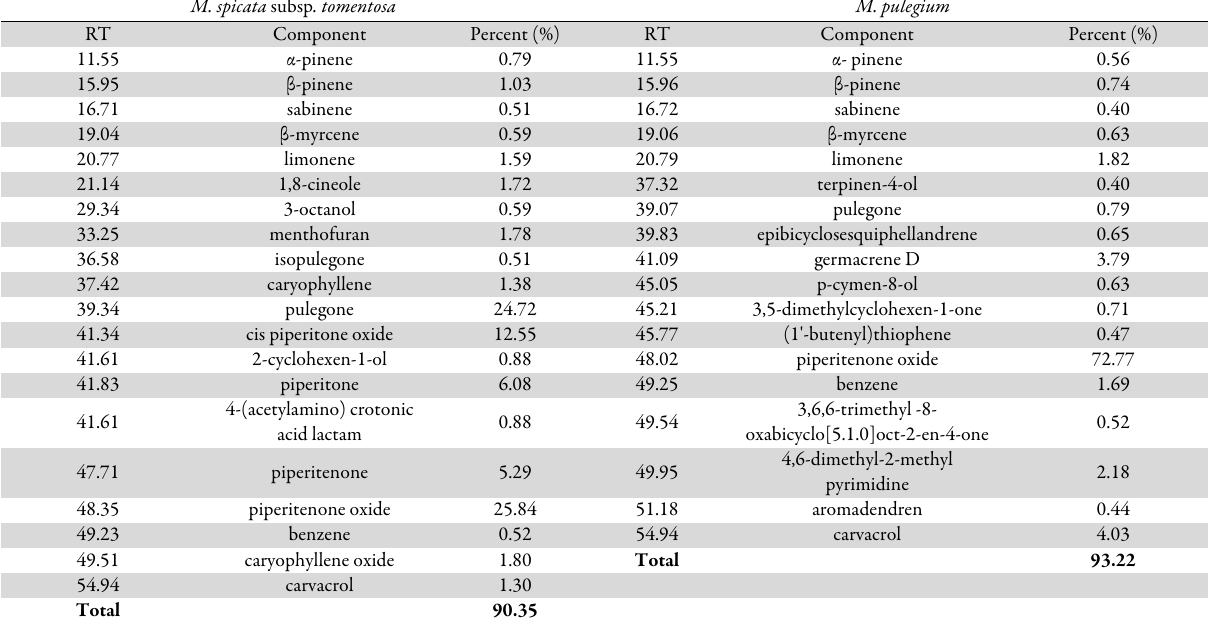
Table 1. Essential oil composition of M. spicata subsp . tomentosa and M.